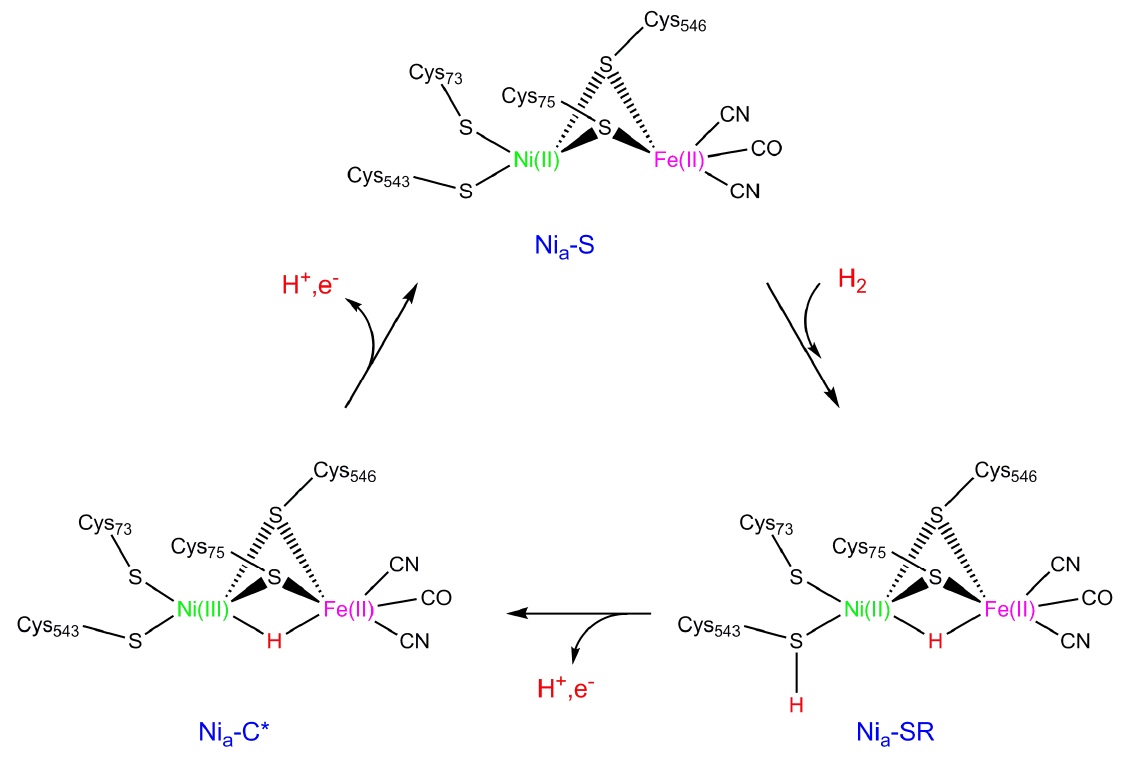
Figure 2. Schematic drawing of the catalytic cycles for NiFe-hydrogenases, suggested by experiments. Adapted from [31], Copyright © 2007, American Chemical Society.